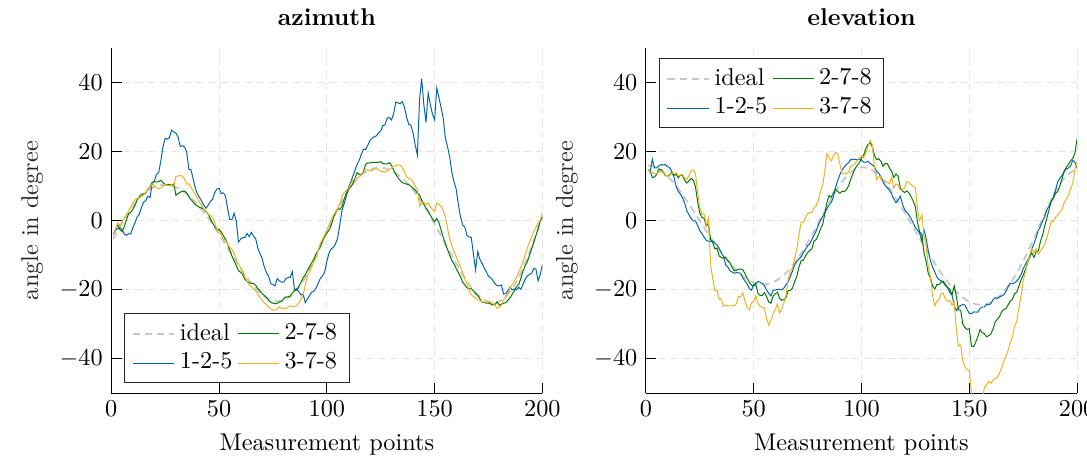
Figure 9. Beam-tracking results for the three worst-case scenarios involving only three of eight antenna elements with a small